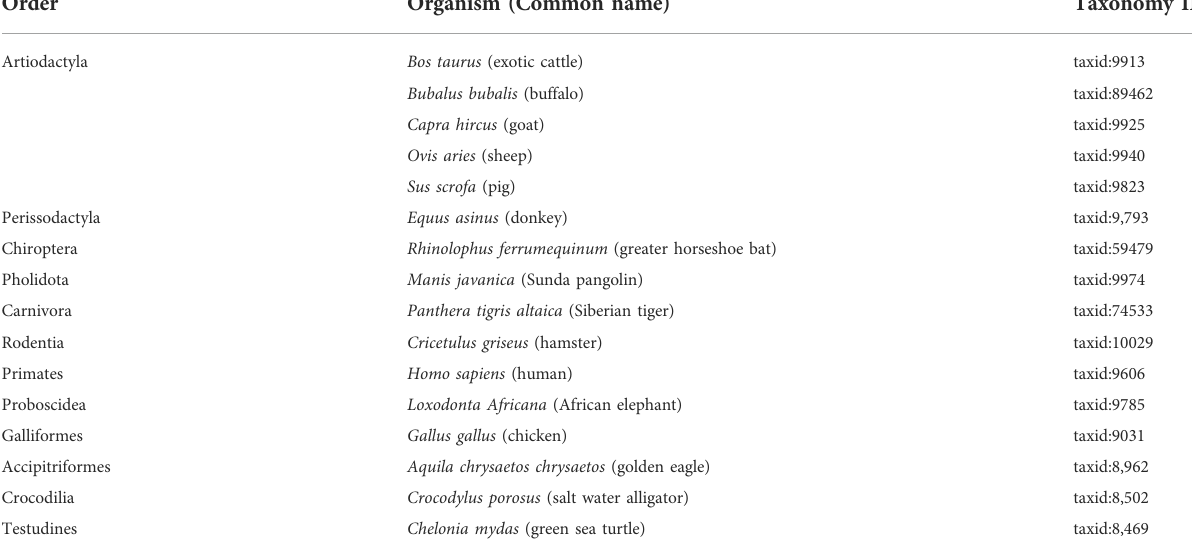
TABLE 1 Table showing the list of 16 different organisms with their taxonomy IDs and their orders.